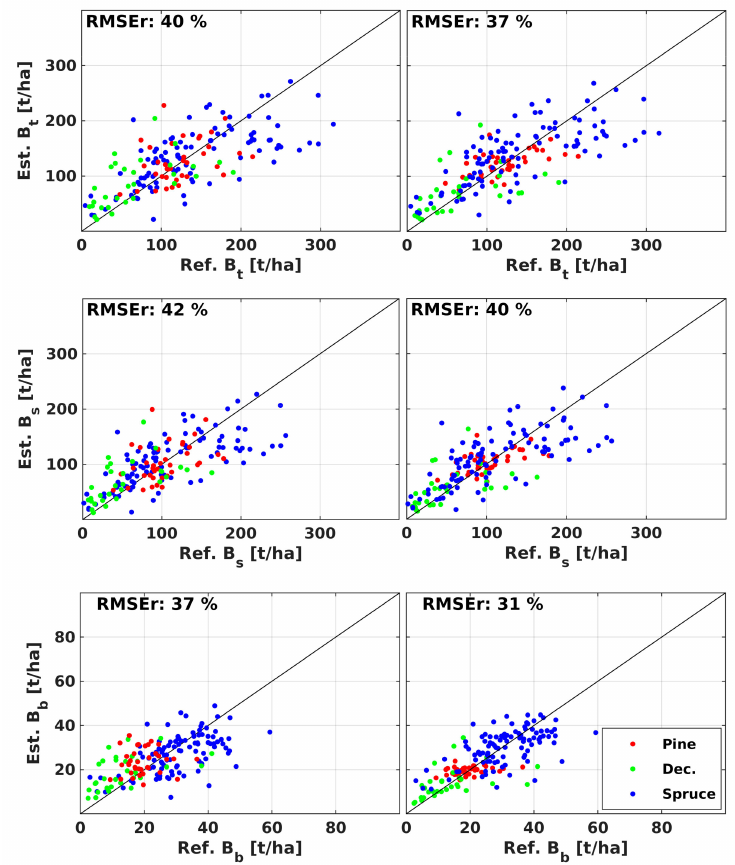
Figure 8. Comparison of in situ plot-level values of above-ground, stem, and branch biomass with radar-derived estimates obtained without ( left column ) or with ( right column ) consideration of species in the model